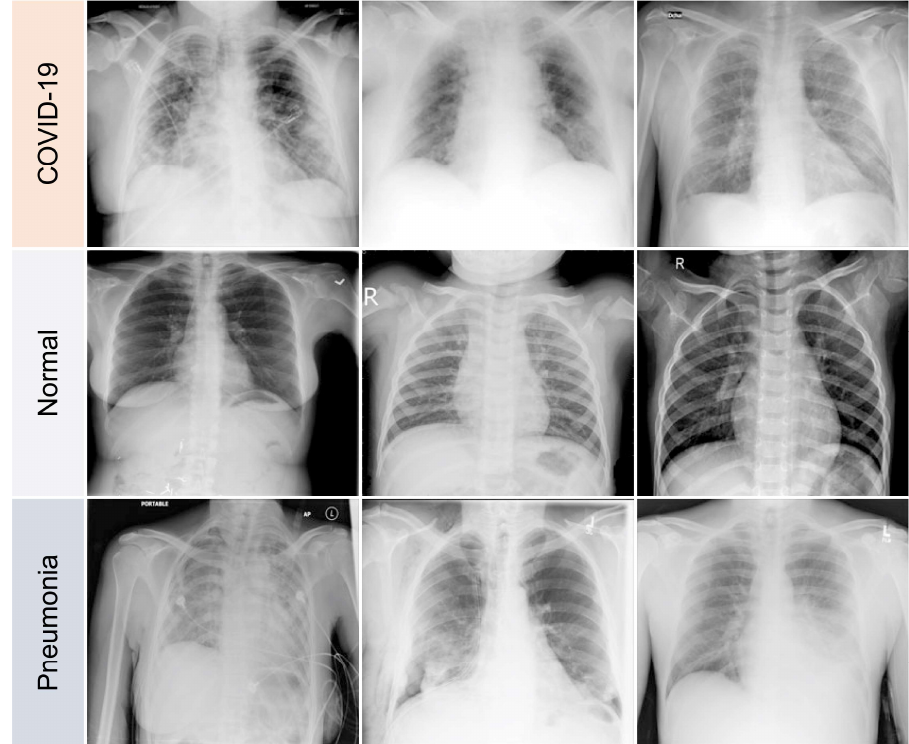
Figure 3. Samples of dataset used in the study.